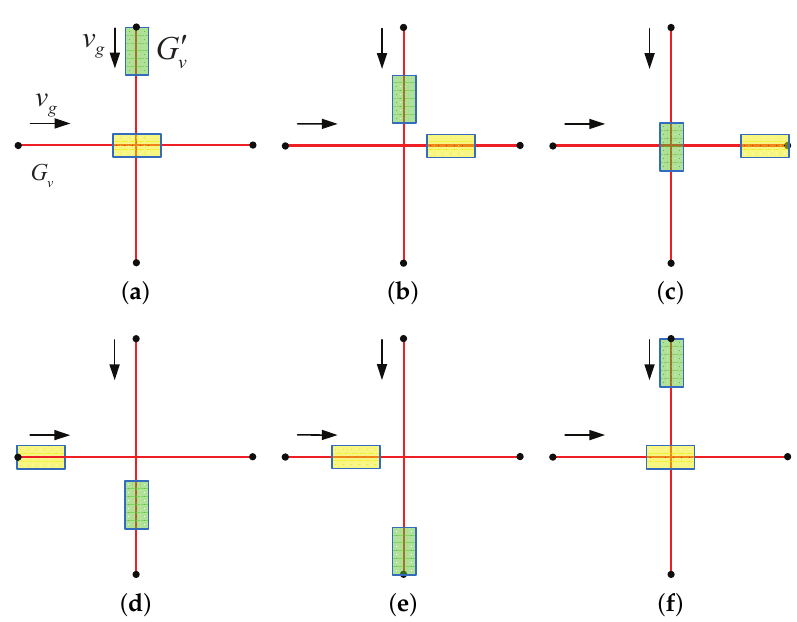
Figure 9. Motion of two VGs without collision, ( a ) t = t 0 + ∆ t , ( b ) t = t 0 + 1 t c + ∆ t , ( e ) t = t 0 + 4 t c + ∆ t , ( f ) t = t 0 + t c + ∆ t . ( d ) t = t 0 + 3 5 5 The collision checking algorithm for two uniform VGs is shown in Algorithm 1.